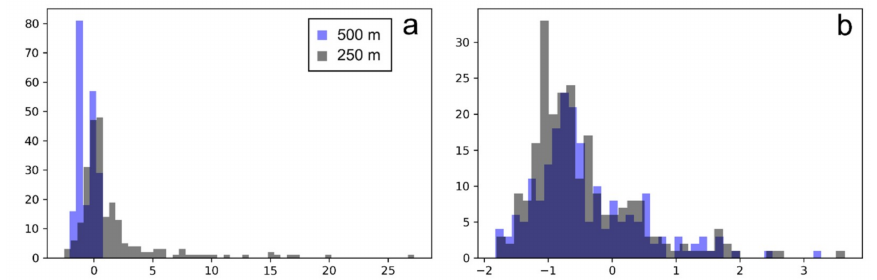
Figure A3. Histograms of ( a ) magnetic and ( b ) Th training data taken from grids at different resolutions. Data are normalized by standard deviation (x-axis). A loss of information is noticeable when changing the cell size from 250 to 500